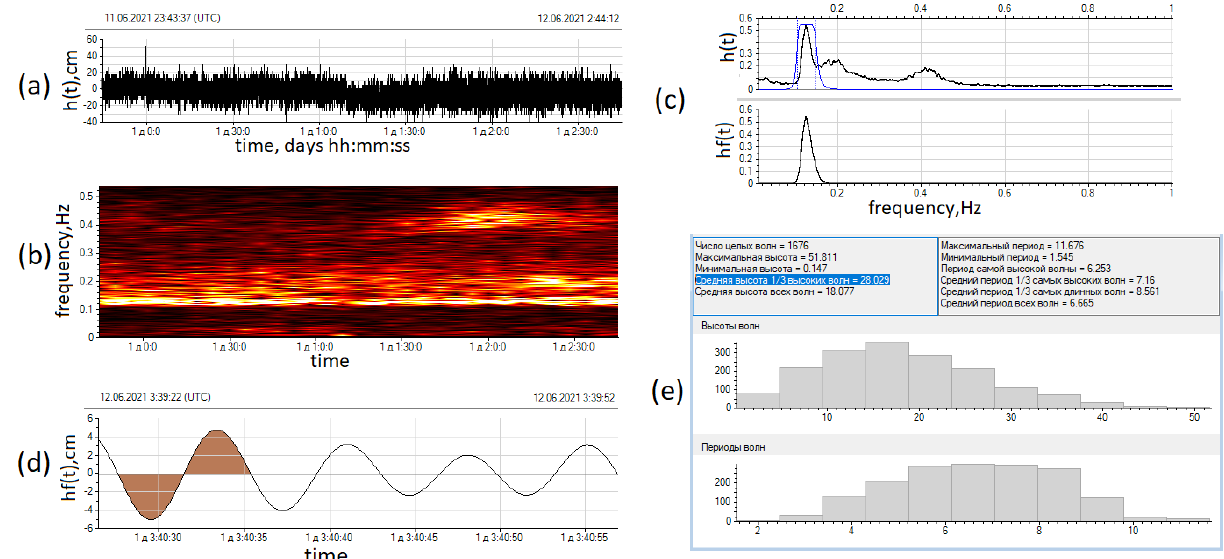
Figure 12. Methodology for calculating the significant wave height (SWH) implemented in OceanSP: ( a ) initial three-hour signal h ( t ); ( b ) its spectrogram, the swell response is a bright band in the low-frequency region; ( c ) at the top is the spectrum of the signal h ( t ) (black graph) and the frequency response of the band-pass (blue graph); at the bottom is the spectrum of the filtered signal hf ( t ); ( d ) signal fragment hf (t), one of the waves separated by the downward zero crossing algorithm is shaded in brown; ( e ) OceanSP information window with the results of statistical analysis of the set of selected waves.